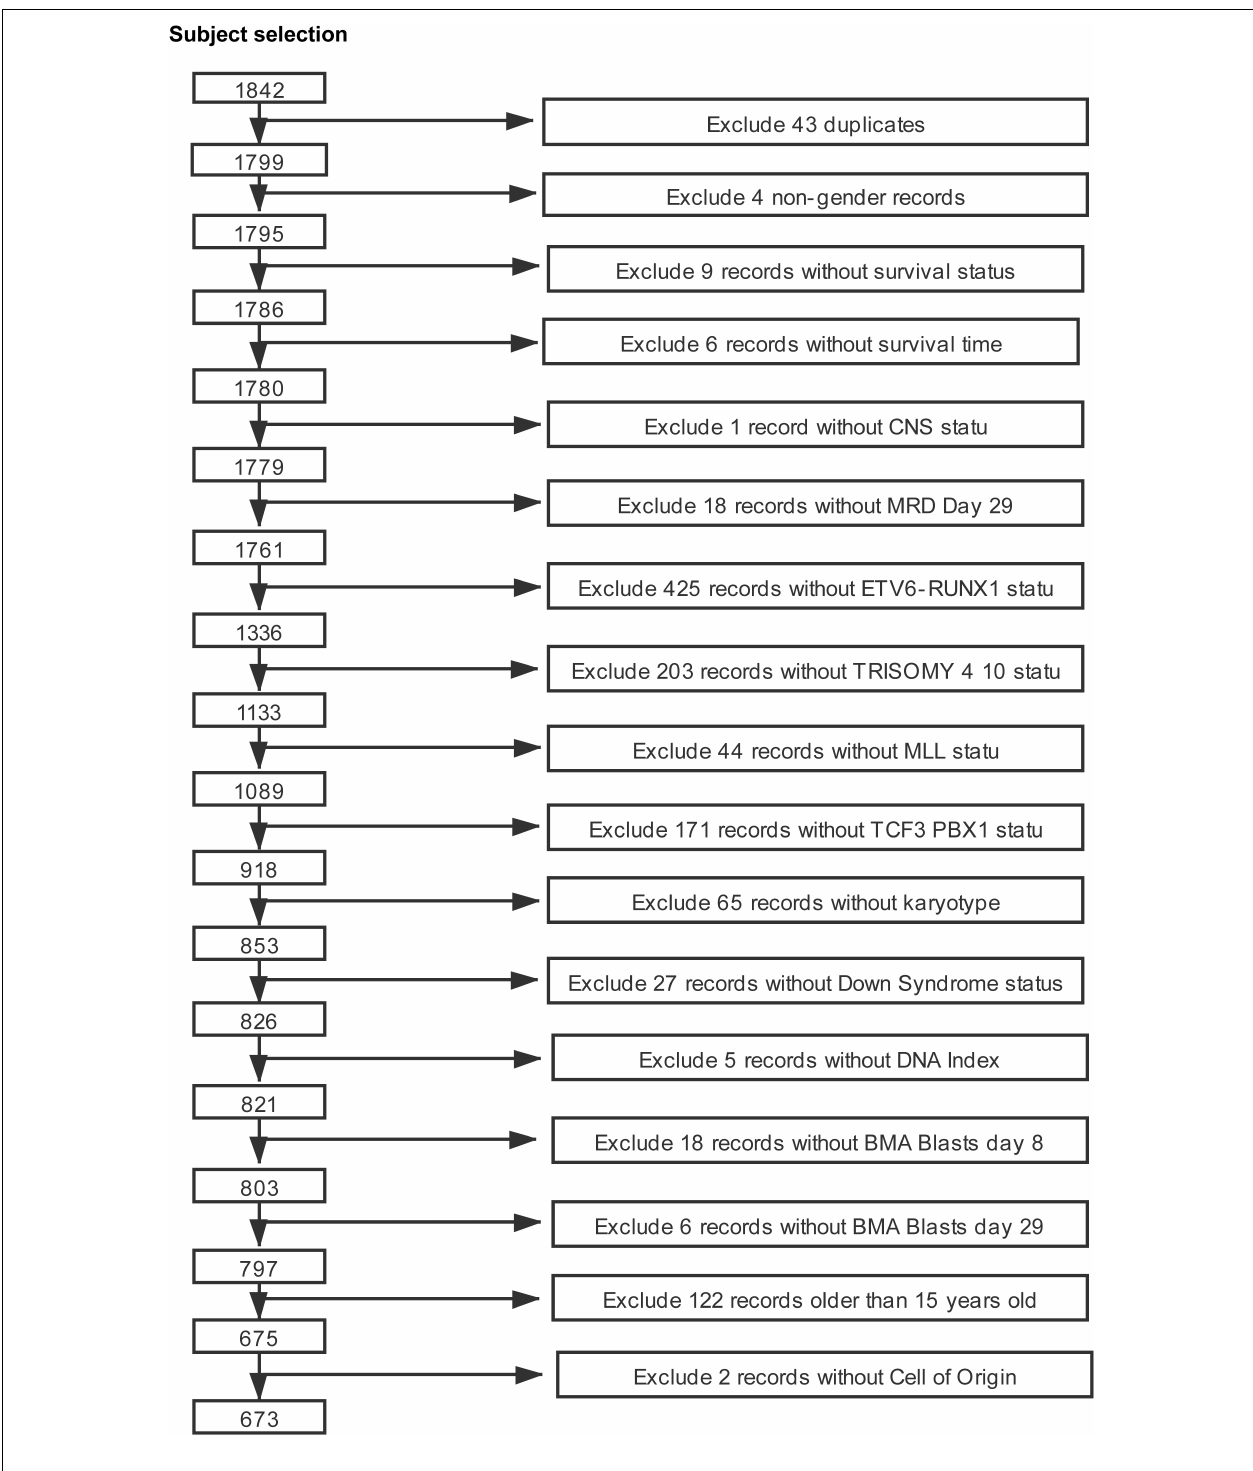
Next, CNS status at diagnosis was divided into three groups: CNS1, CNS2, and CNS3. MRD day 29, which means minimum residual disease status at day 29 of induction therapy, was